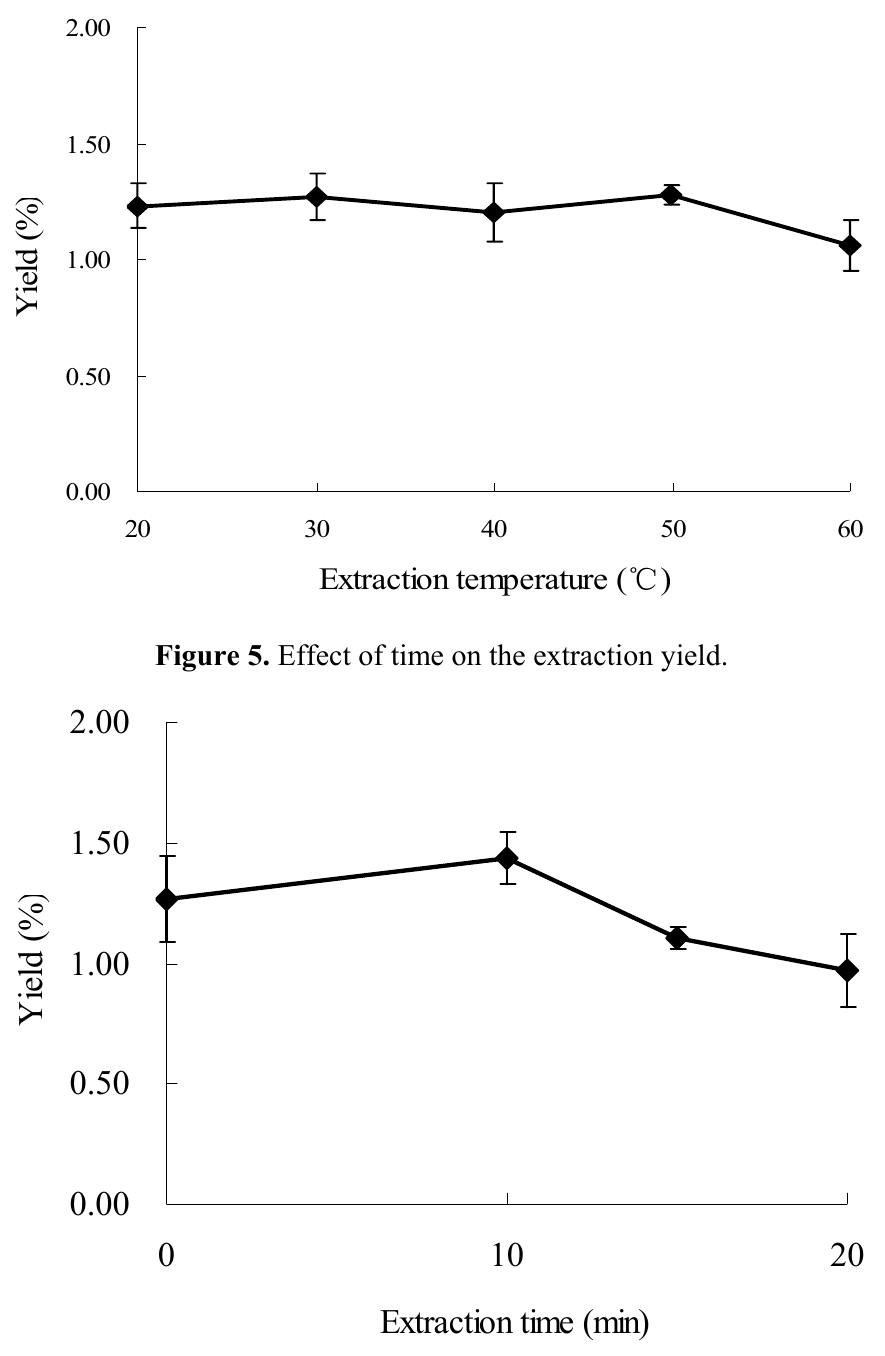
Figure 4. Effect of temperature on the extraction yield.